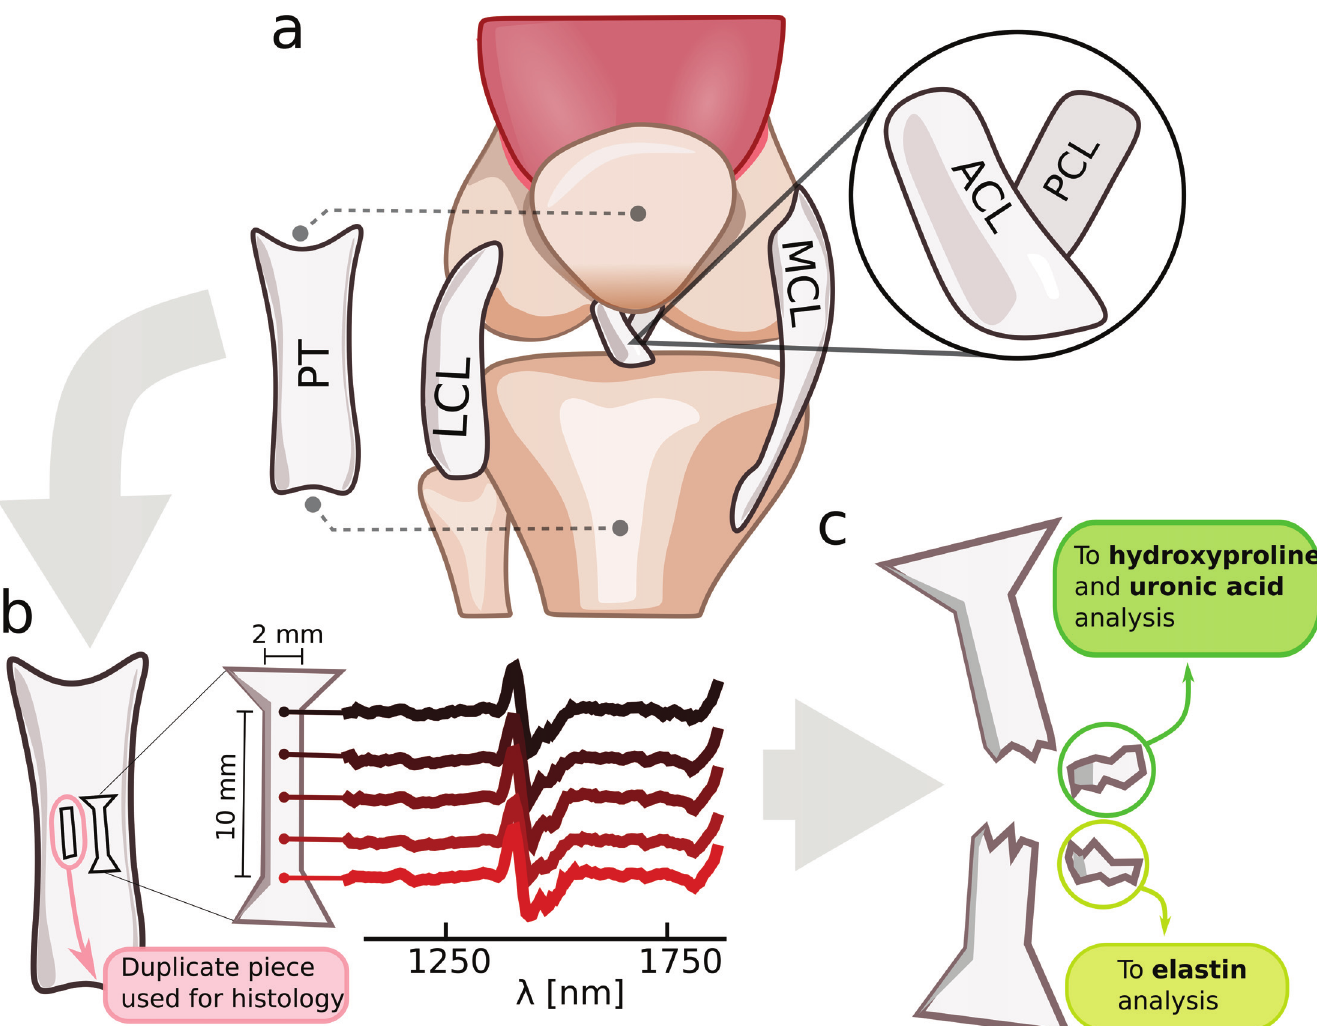
Fig 2. Sample processing and measurement techniques. a : Four knee ligaments and the patellar tendon were extracted from 10 bovine stifle joints (right human knee used here for visualization purposes). b : Full ligaments were cut into smaller sample pieces which were then measured using NIRS from five equispaced locations along the longitudinal axis. A duplicate piece of tissue adjacent to the sample piece was extracted for histological analysis which determined the length and angle of the collagen crimp. c : The ligament samples were subjected to destructive mechanical testing protocol (see [32] for details) which ruptured the samples. Pieces of the samples were then used for hydroxyproline, elastin, and uronic acid